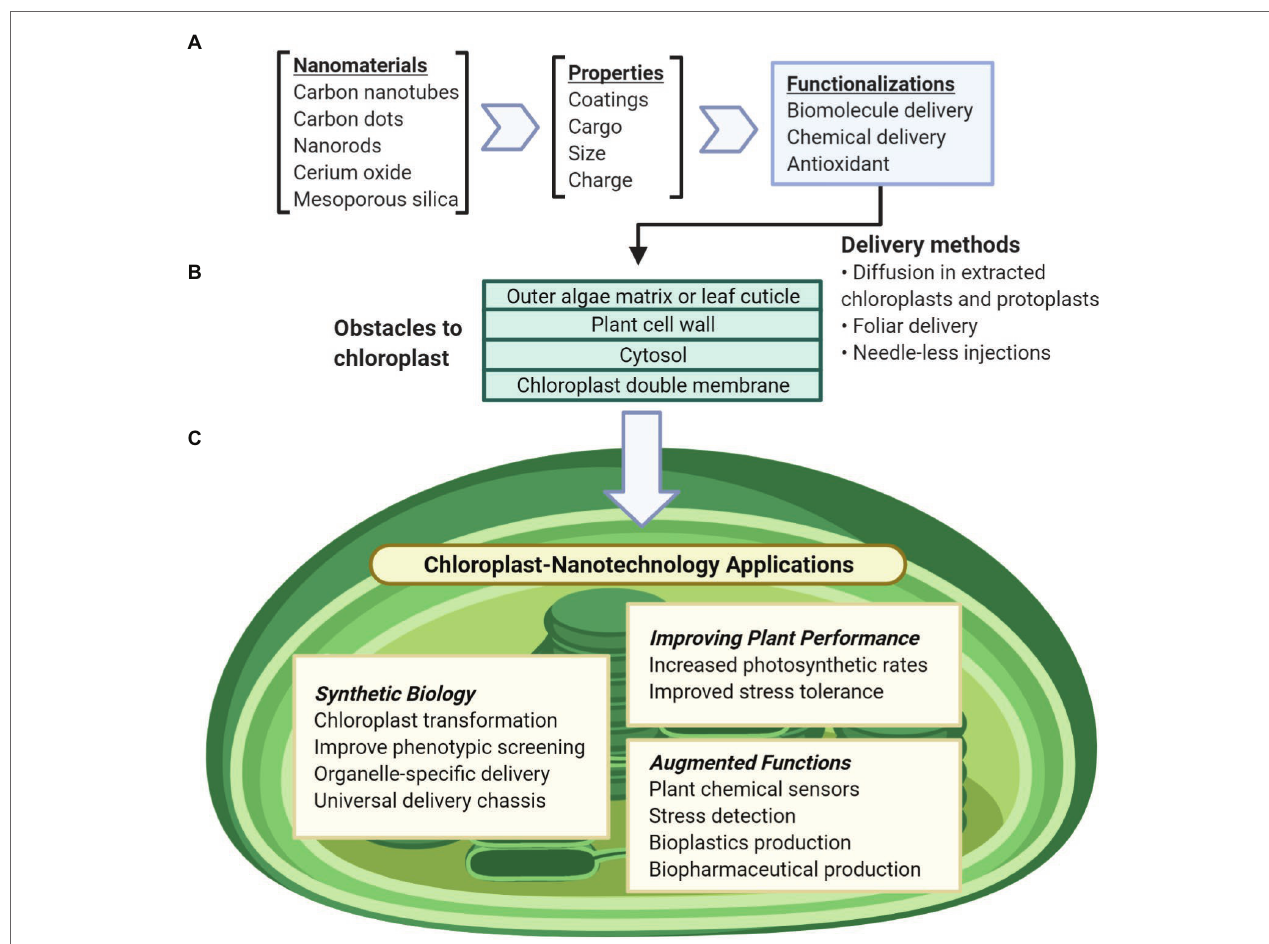
FIGURE 1 | Overview of nanotechnology approaches for chloroplast biotechnology. (A) Nanomaterial properties can be modularly tuned for a variety of functions including biomolecule and chemical delivery, biosensors, antioxidants. (B) Nanomaterials can be delivered to chloroplasts in liquid suspensions by passive intake without mechanical aid or through needleless-syringes and foliar spray. To reach the chloroplast, these particles pass through obstacles of the plant cell including the outer leaf cuticle or the glycoprotein-rich extracellular matrix of algae, the plant cell wall, the plant cell membrane, the cell cytosol, and lastly the